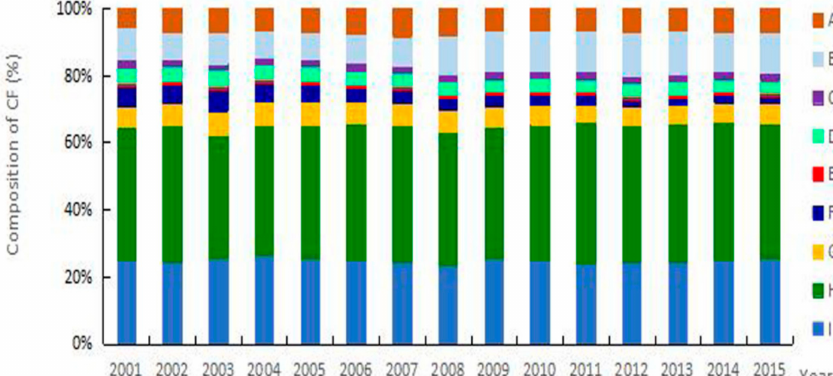
Figure 4. Composition of CFs for crop production in the HLRA (2001–2015). A: Plastic film; B: Electricity; C: Pesticide; D: P fertilizer; E: K fertilizer; F: Seed; G: Diesel; H: CH 4 ; I: N fertilizer + N 2 O.